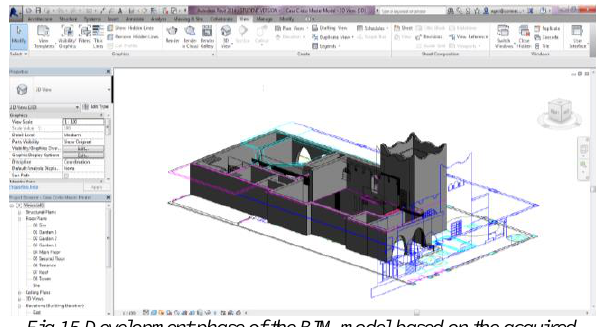
Fig.15 Development phase of the BIM model based on the acquired data. Author: Wei Yi